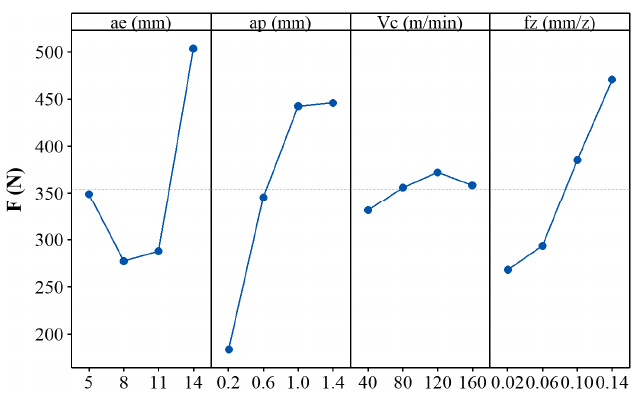
Figure 4. Plot of means for the maximum cutting force F .